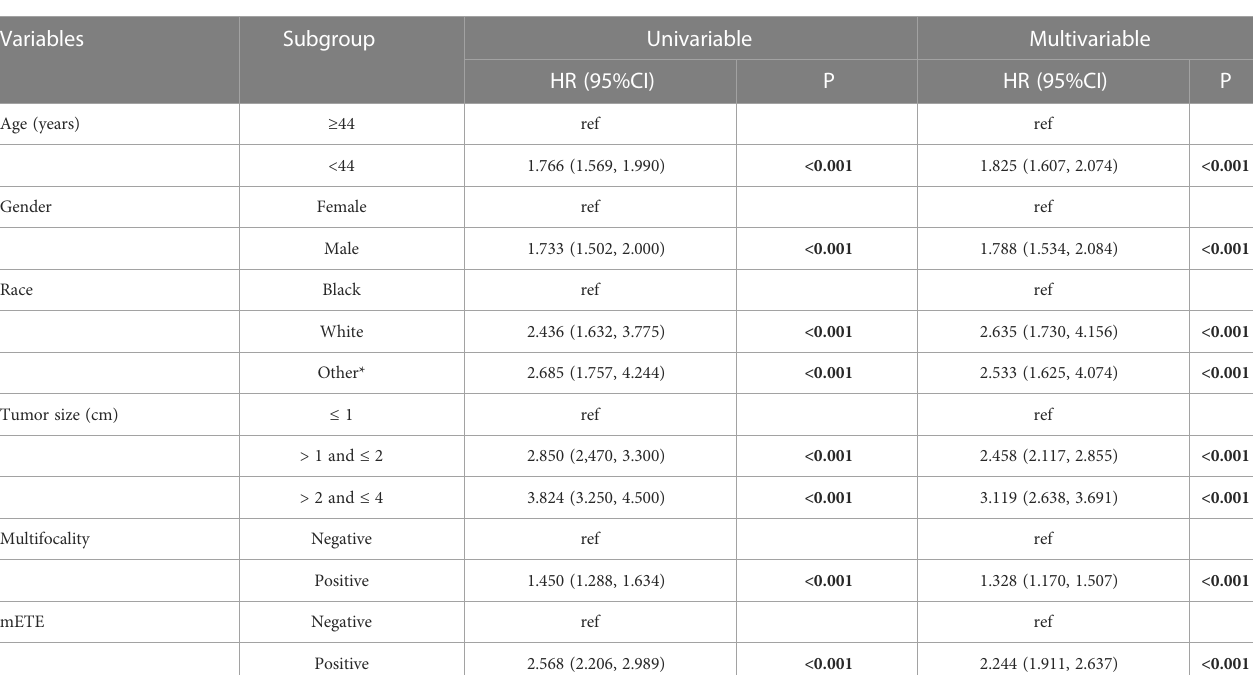
TABLE 2 Univariate and multivariate analysis of risk factors associated with CLNM.